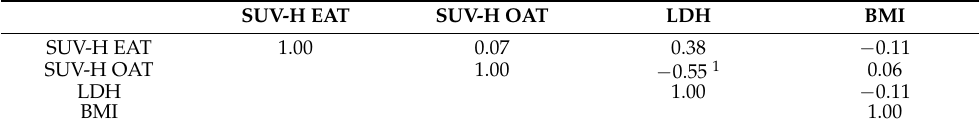
Table 5. Pearson’s correlation analysis of initial SUV-H EAT and OAT volumes, LDH levels, and BMI. SUV-H EAT